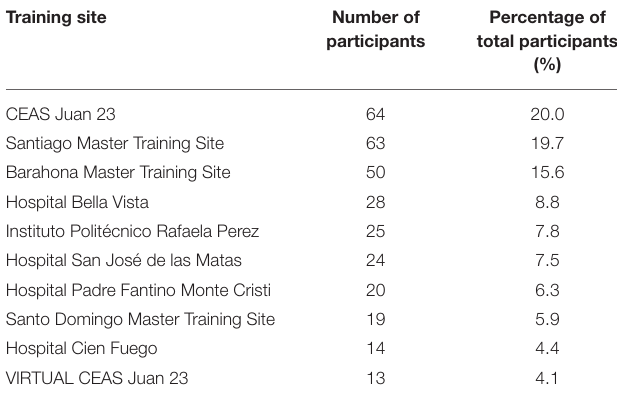
TABLE 1 | Breakdown of number of participants per training